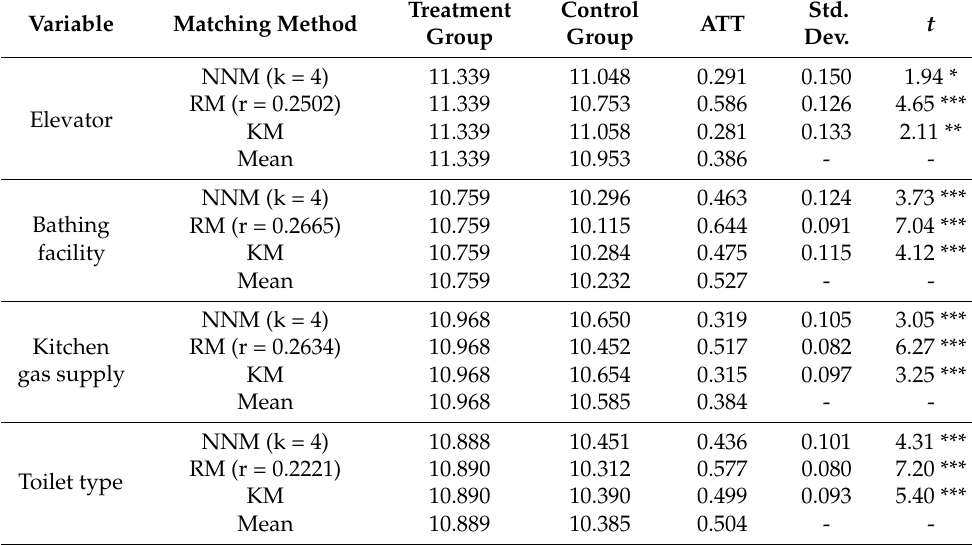
Table 5. The influence on